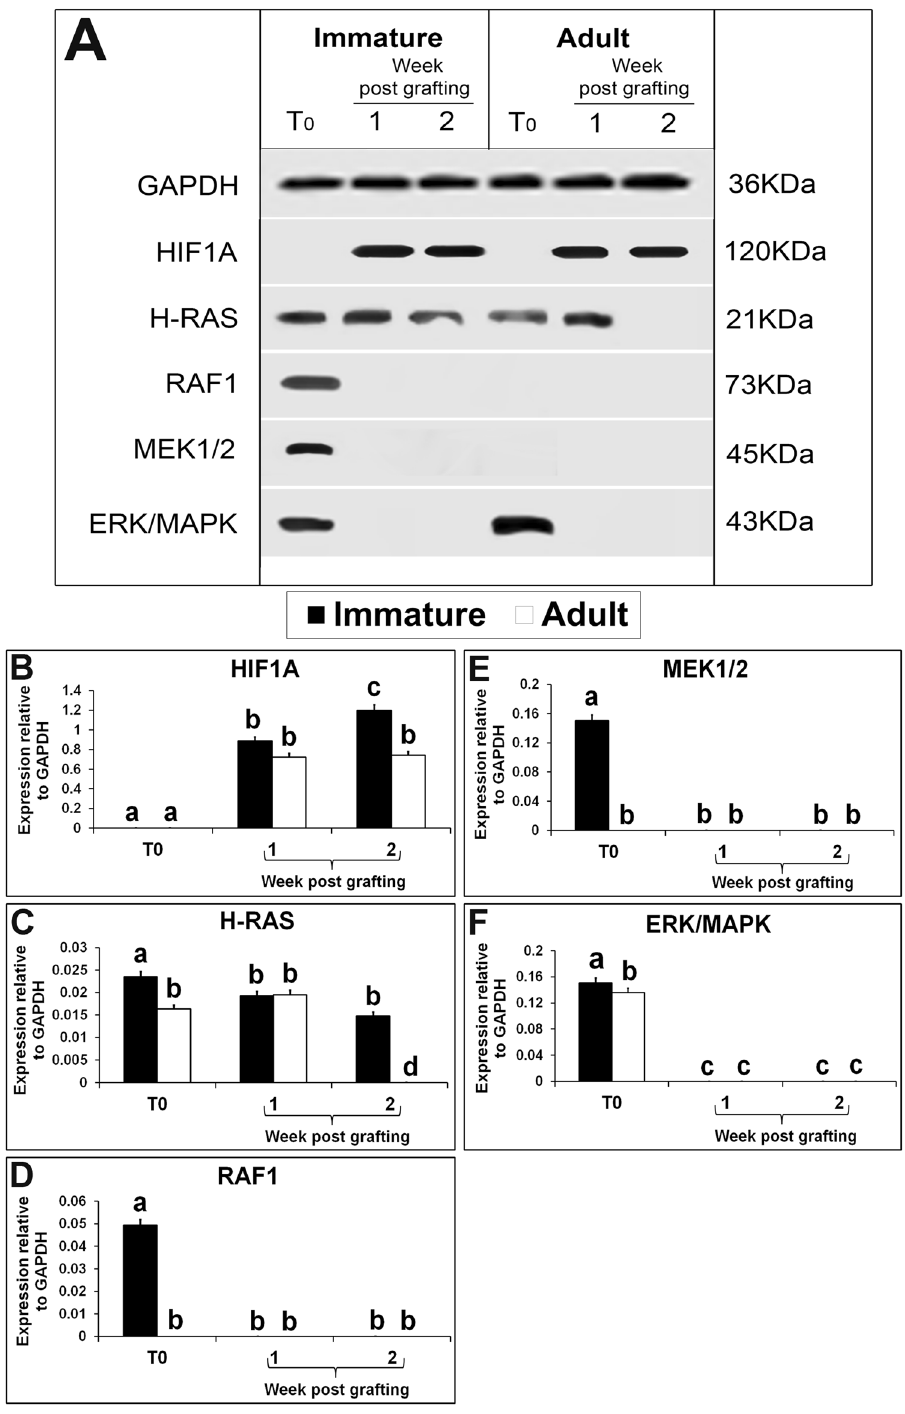
Figure 5. Western blot analysis of xenografted immature and adult testes at 1-and 2-wk-post grafting for expression of hypoxia and ERK/MAPK pathway proteins. Protein expression in 6-day-old and 10-wk- old donor testes before grafting (T0) are presented as starting material. Representative blot ( A ) and densitometry analysis of ( B ) HIF1A, ( C ) H-RAS, ( D ) RAF1, ( E ) MEK1/2, ( F ) ERK/MAPK protein. Y-axis represents intensity of bands relative to GAPDH. Data are presented as mean ± SEM. Bars with different letters are significantly different at P <